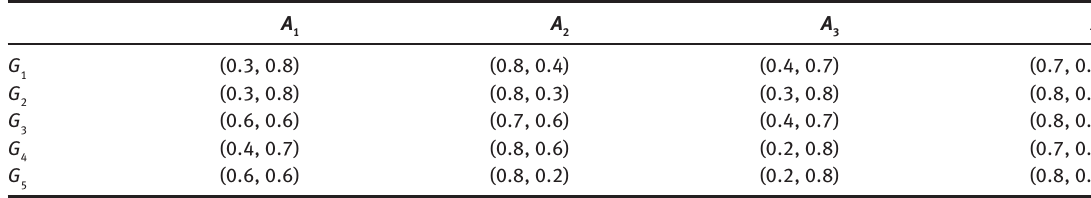
Table 8: Normalized Decision Matrix R 4 .